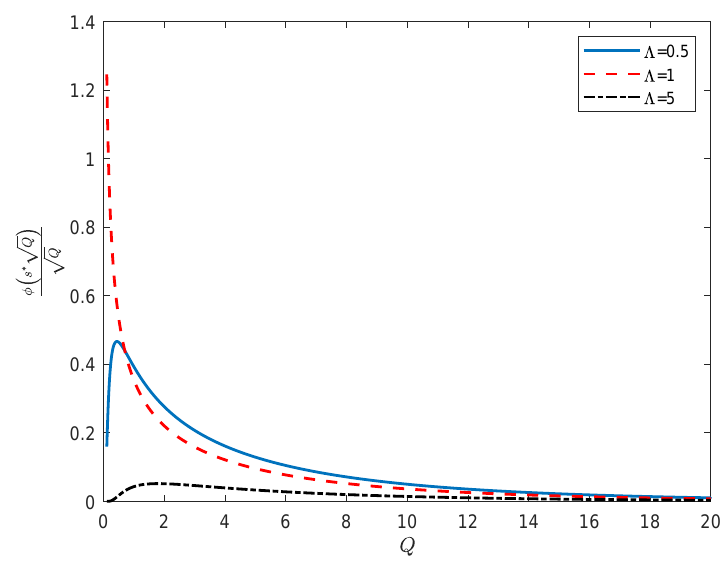
Figure 1. Marginal